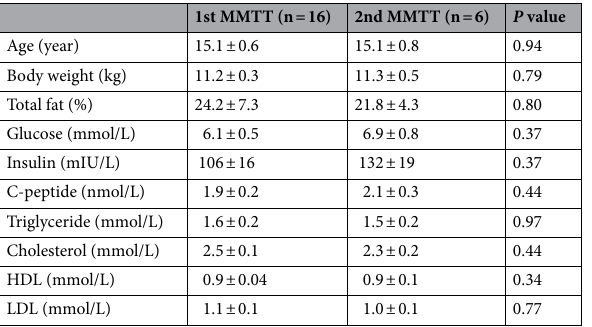
Table 1. General characteristics of the enrolled cynomolgus monkeys. Values are expressed as mean ± SEM. P value, versus 1st MMTT